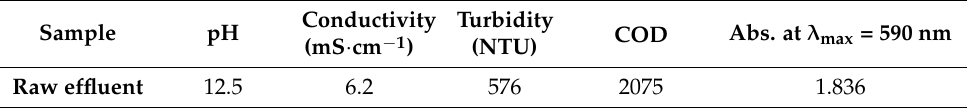
Table 4. Physicochemical characteristics of the textile effluent